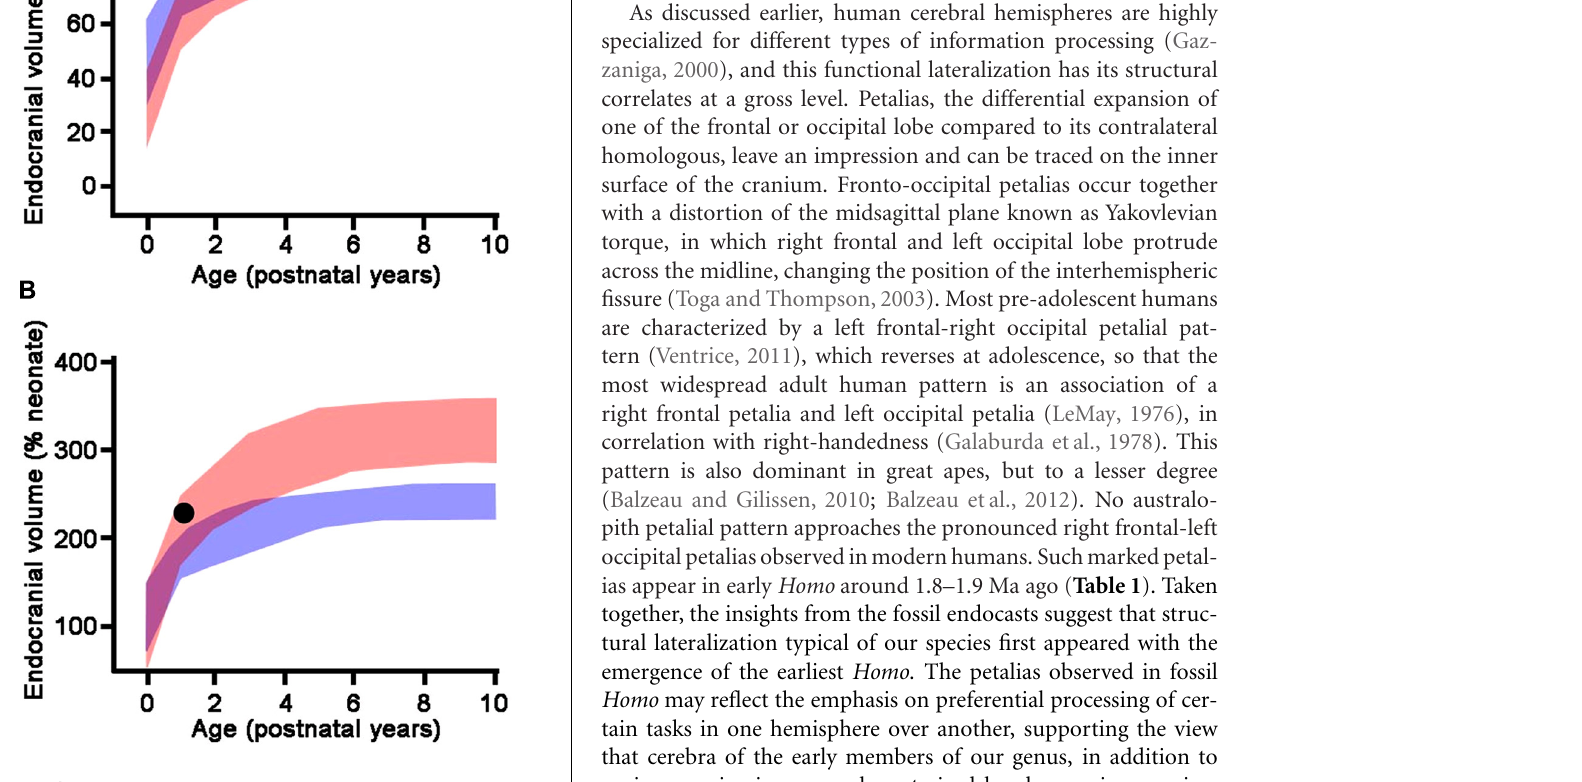
FIGURE 2 | Endocranial growth trajectories as a proportion of adult endocranial volume (A) and neonatal endocranial volume (B). Red areas represent modern human growth trajectories (mean ± 1 standard deviation). Blue areas represent growth trajectories for chimpanzees (mean ± 1 standard deviation). Purple areas represent overlap between human and chimpanzee growth trajectories. Black dot: Homo erectus (Mojokerto) infant dated at 1.8 Ma (average values for estimated age, expected adult endocranial volume, and predicted neonatal endocranial volume). As a percentage of its expected adult endocranial volume, the Homo erectus child follows a growth trajectory similar to chimpanzees, while as a percentage of its predicted neonatal endocranial volume, he falls within the modern human range of variation.This particular pattern accounts for the lower endocranial volume of Homo erectus compared to modern humans (high percentage of adult endocranial volume reached early in ontogeny), associated with an early postnatal brain growth spurt. Adapted from Zollikofer and Ponce de León